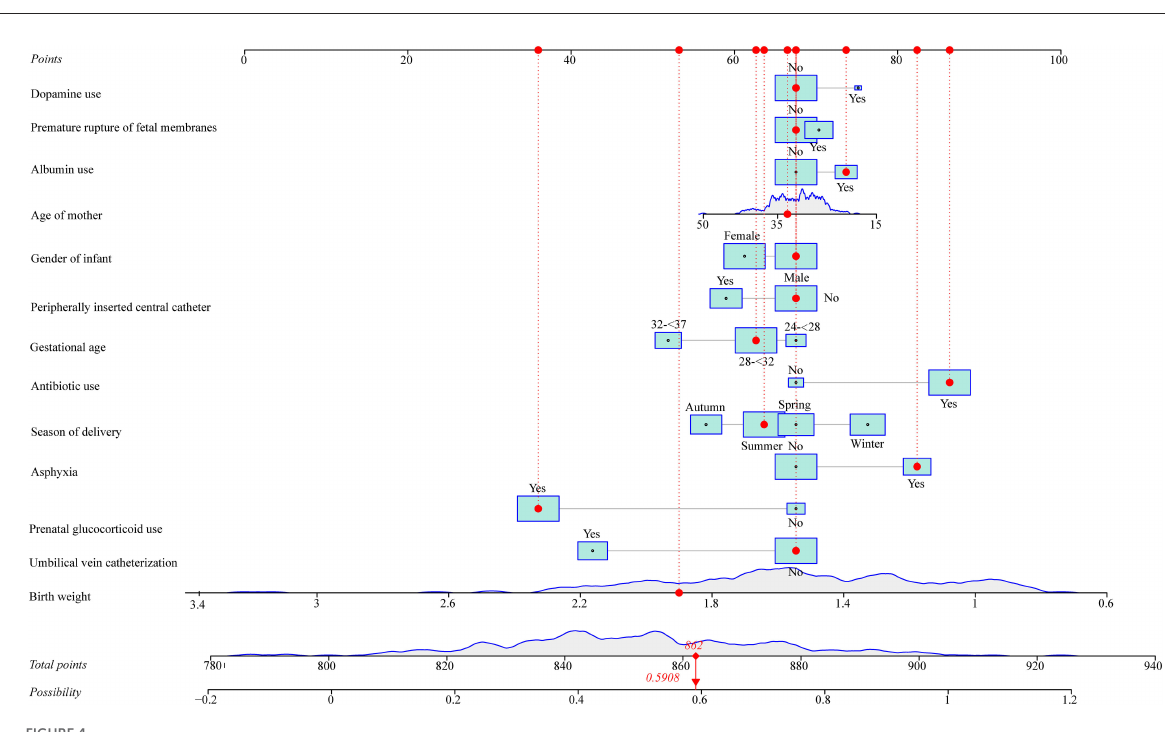
FIGURE4 A sample was randomly selected from the training set to validate the performance of the prediction